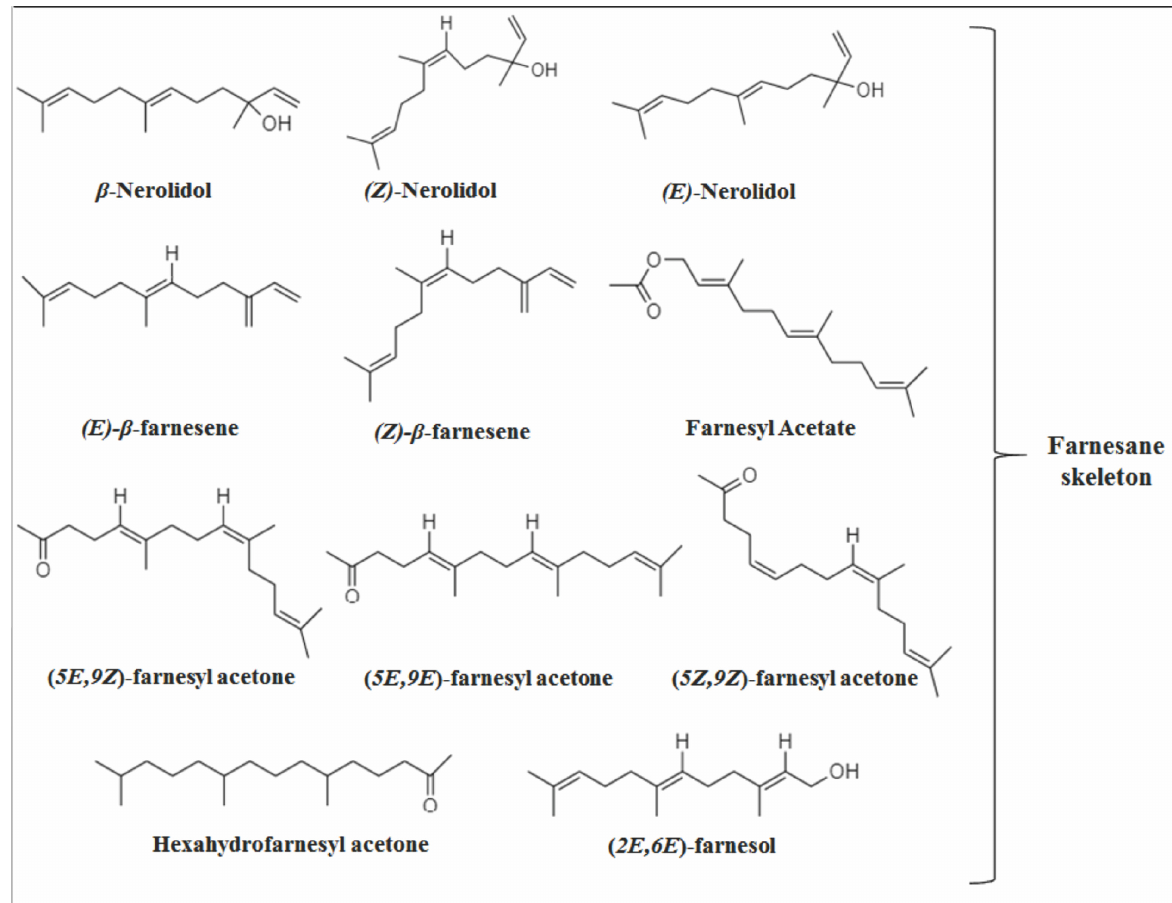
Figure 3. Structure of acyclic sesquiterpenes in Vitex species.